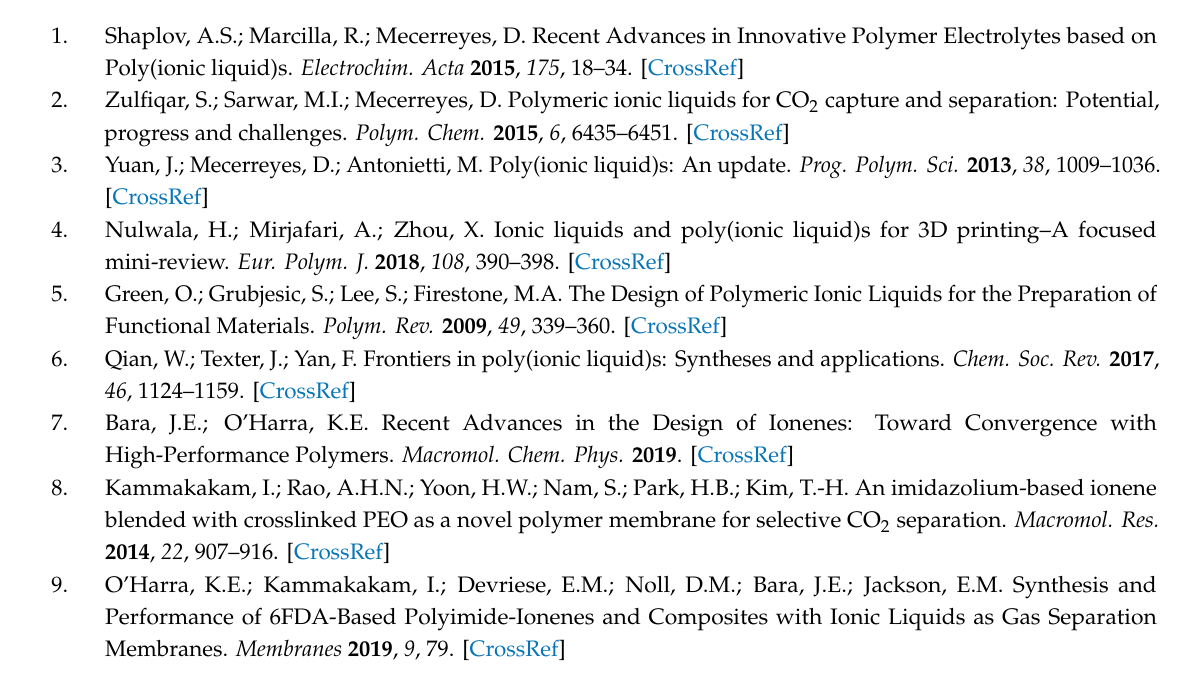
ionenes, Figure S13: TGA data for PAA and PAI ionenes, Figures S14 and S15: DSC Data for PA and PI composites with [BTA(MeIm + ) 3 ][Tf 2 N - ] 3 , Figure S16: PLM images for PAA and PAI composites with [Bnmim][Tf 2